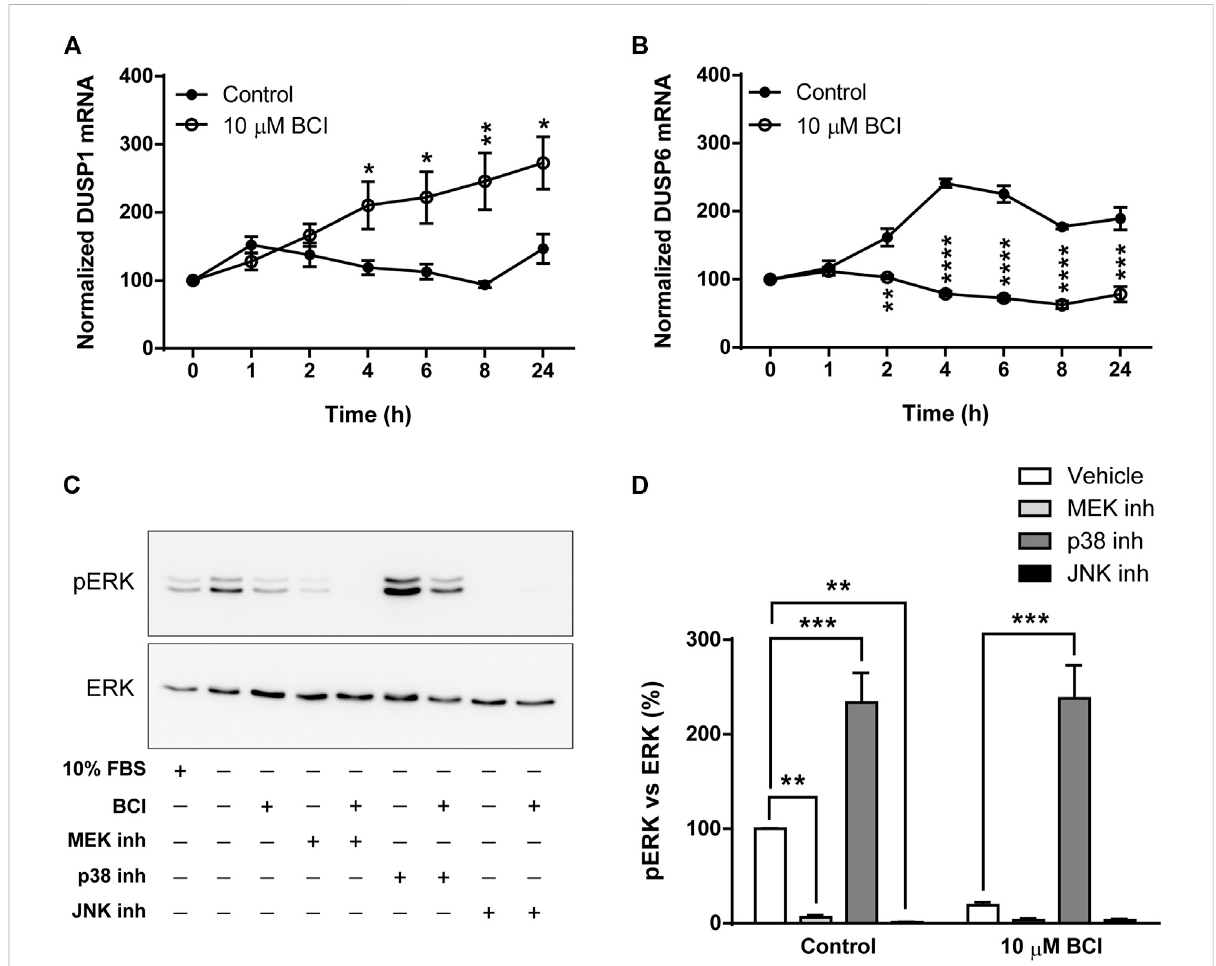
Inhibitionofp38preventsdephosphorylationofERK1/2byBCIinneuroblastomacells.N2acellswereincubatedinSFMfor1,2,4,6,8or24 hin thepresenceorabsence(control)ofBCI(10 μ M).Total RNAwasextracted fromthecellsand quanti fi ed.The expression ofDUSP1 (A) andDUSP6 (B) mRNAs was determined and normalized to the DUSP1 or DUSP6 transcript levels in cells cultured in complete medium (time = 0, set as 100%). The resultsareshownasthemean±SEMof fi veindependentexperimentsperformedintriplicate.* p ≤ .05,** p ≤ .01,*** p ≤ .001vs.control. (C) N2a cellsculturedinSFMweretreated withinhibitorsofMEK1/2 (10 μ M, U0126),p38(10 μ M,SB202190) orJNK(10 μ M, SP600125) for10 min beforethe additionofBCI (10 µM)orvehiclealone(control)for1 h.Untreated cellscultured inSFMorcomplete medium (10% FBS)werealso analyzed. Thecell extracts were assayed in immunoblots to detect phospho-ERK1/2 and total ERK. (D) The histogram shows the phospho-ERK1/2 protein levels obtained by densitometry and normalization to the total ERK. The phospho-protein levels where normalized to those on untreated cells cultured in SFM, set as 100%. The values represent the mean ± SEM of fi ve independent experiments performed in duplicate. ** p ≤ .01, *** p ≤ .001 vs.